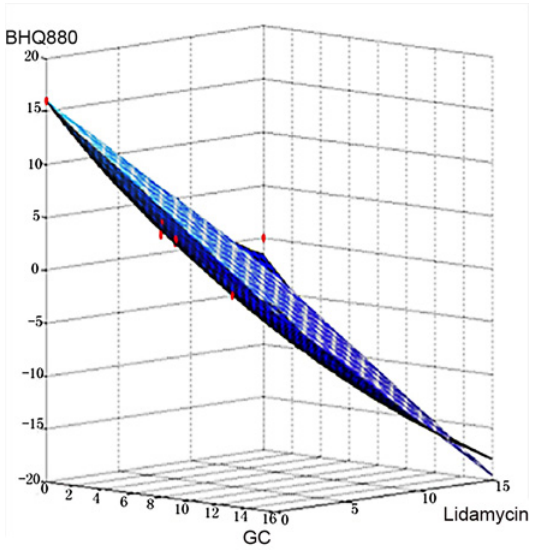
Fig 17. Synergy prediction of the combination of BHQ880, GCs and Lidamycin based on the Loewe combination